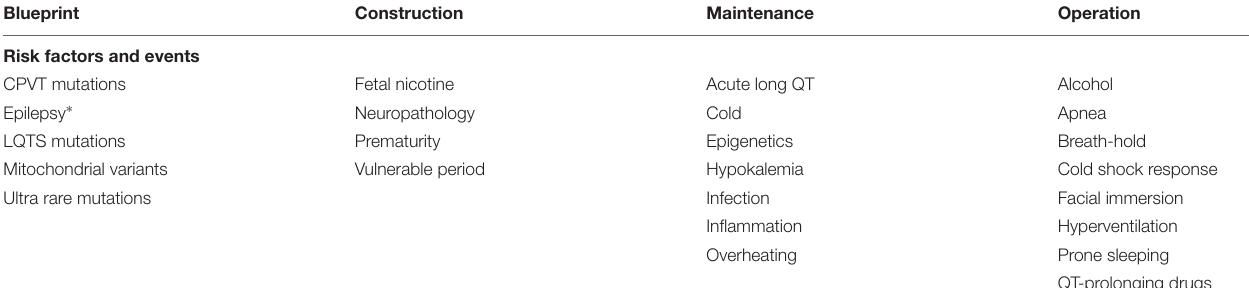
TABLE 1 | SIDS, SUDEP, and SCDIW: multifactorial features of a complex tightly coupled system.